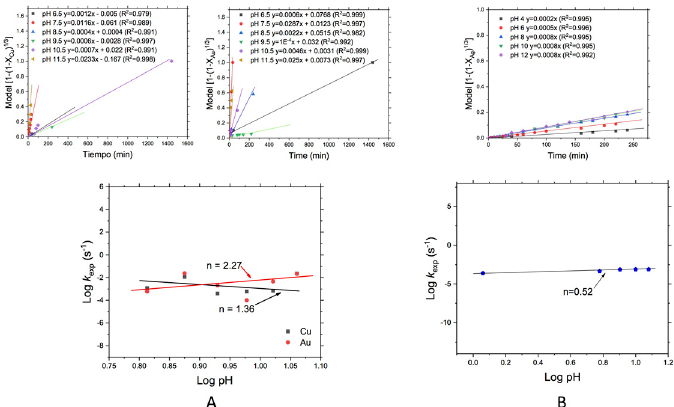
Figure 8. Leaching of ( A ) Au and Cu (from WEEE) and ( B ) Ag (from MW). Effect of the pH.